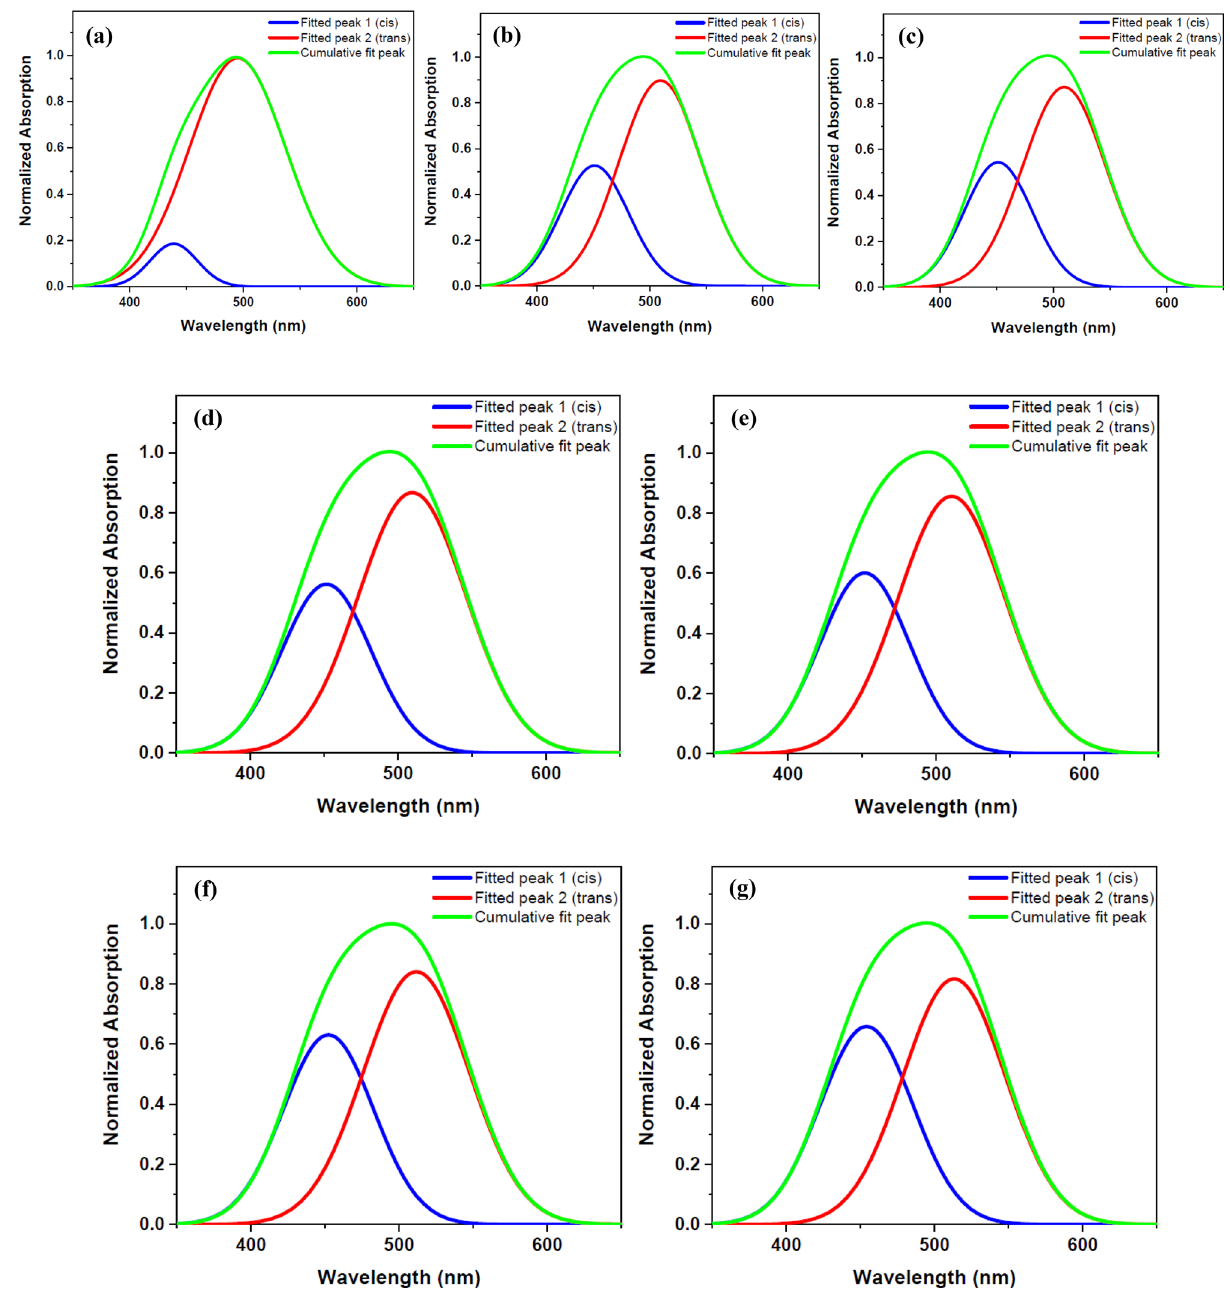
Figure 6. Double peaks fitted for the UV–Vis normalized absorption spectra of DR1 dye-doped PMMA polymer films with extra surface dye before and after plasma modification for different treatment times: ( a